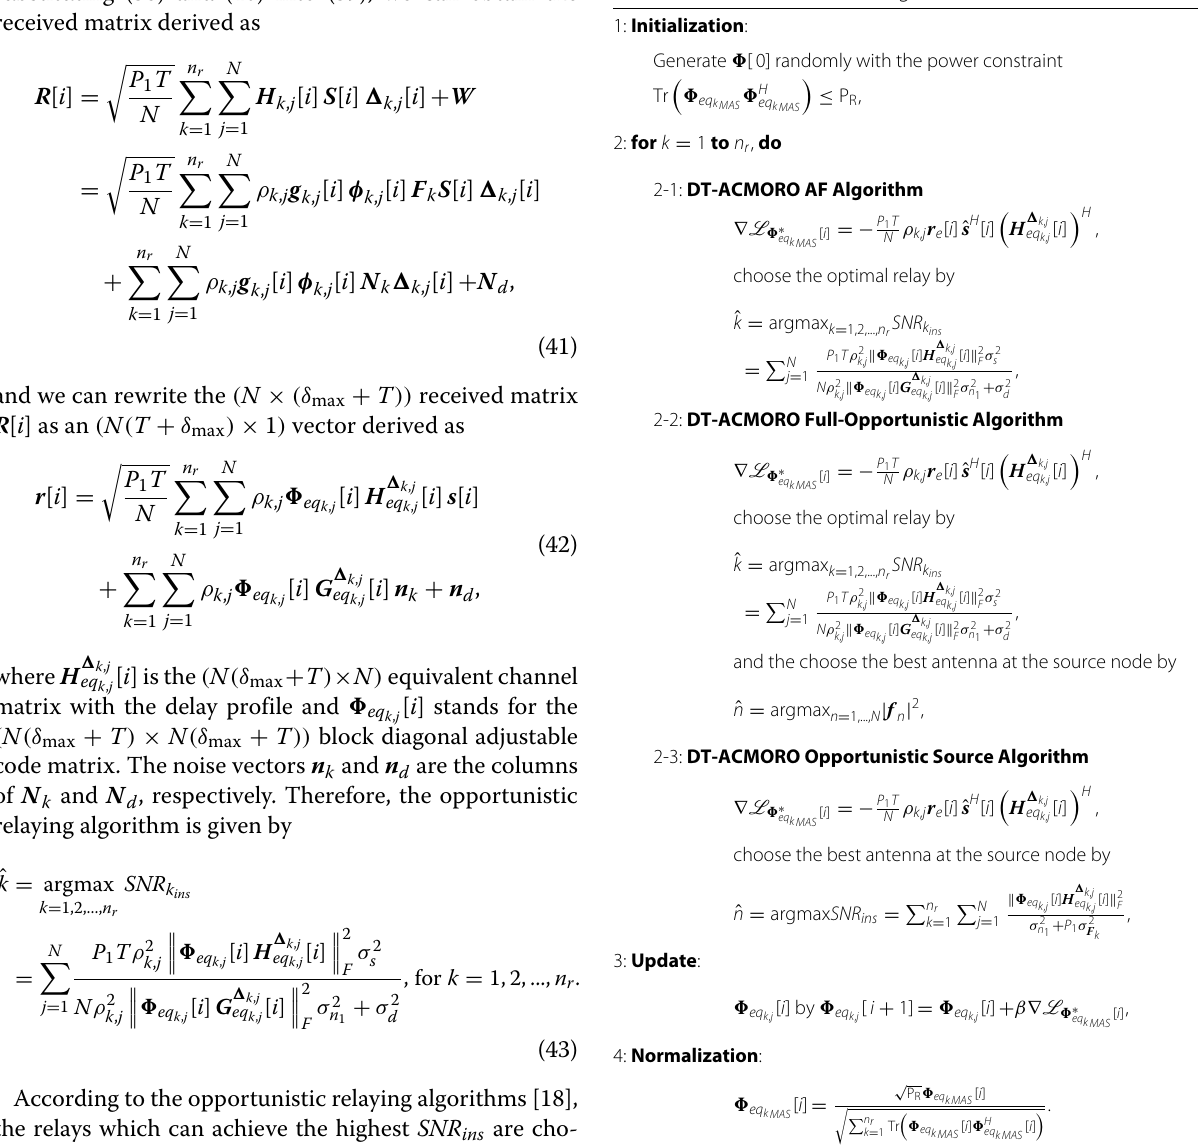
Table 3 The DT-ACMORO SG